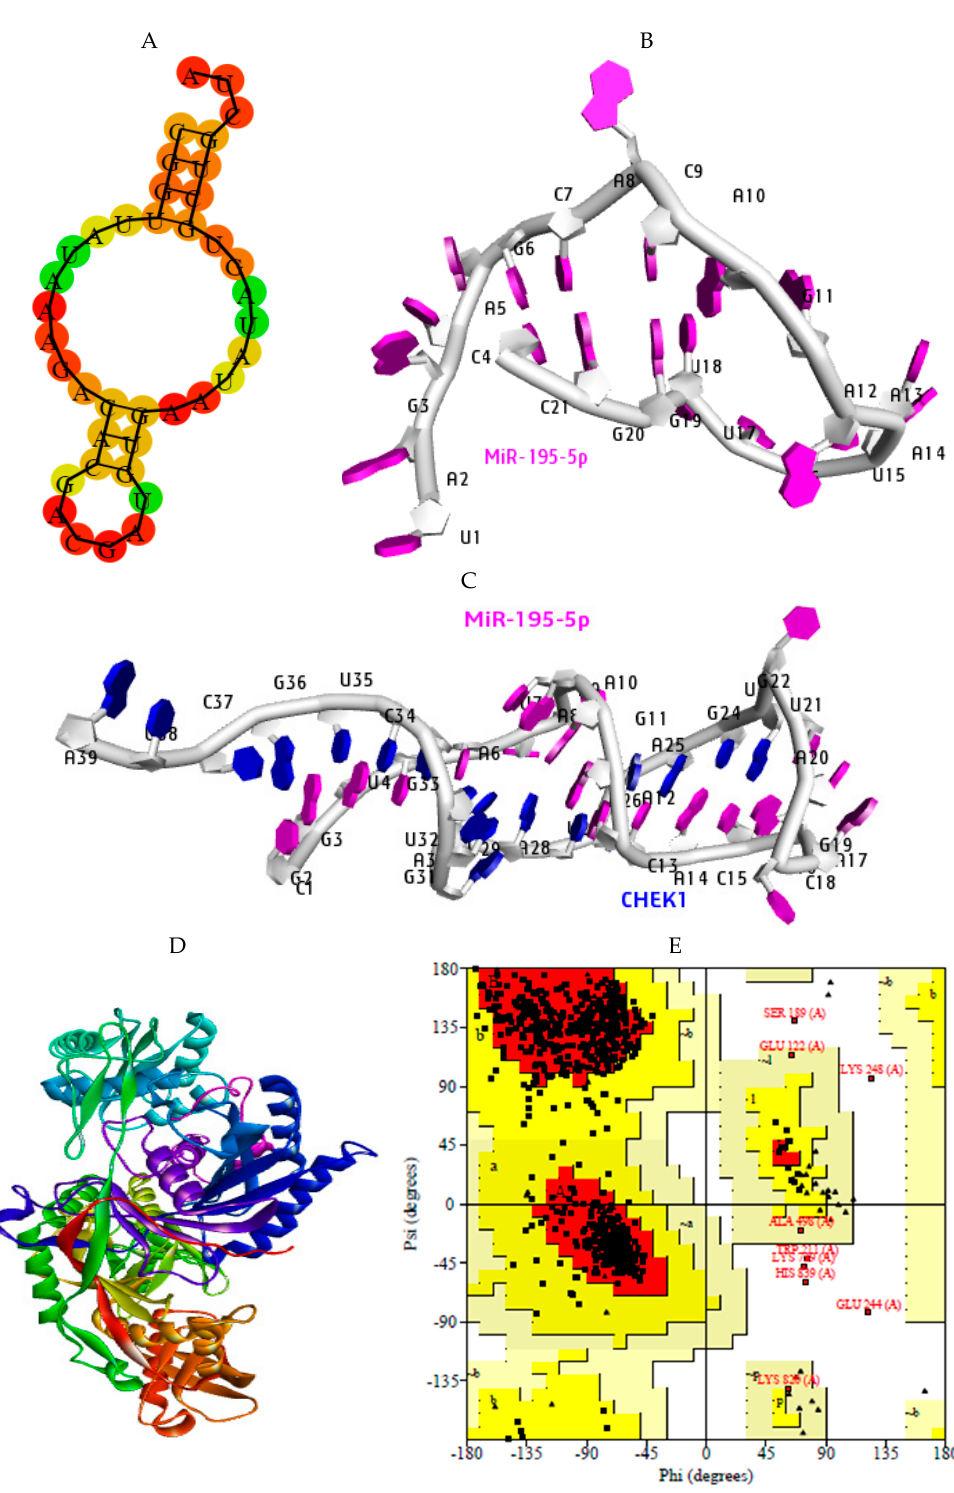
Figure 10. Structural model for molecular docking. ( A ) Secondary structure of MiR-195-5p, 3D structures of ( B ) MiR-195-5p, and ( C ) MiR-195-5p-CHEK1. ( D ) Prepared human argonaute protein (Ago) and ( E ) Ramachandran plot (PDBSum, PROCHECK). The quality of the prepared Ago was estimated by the PDBSum server. The residues in most favored regions (A, B, L), the residues in additional allowed regions (a, b, l, p), and residues in generously allowed regions (~a, ~b ~l, ~p). The structural details of Ago (ID: 4F3T: A) consist of 7 sheets, 9 gamma turns, 13 beta hairpins, 7 beta bulges, 37 strands, and 68 beta